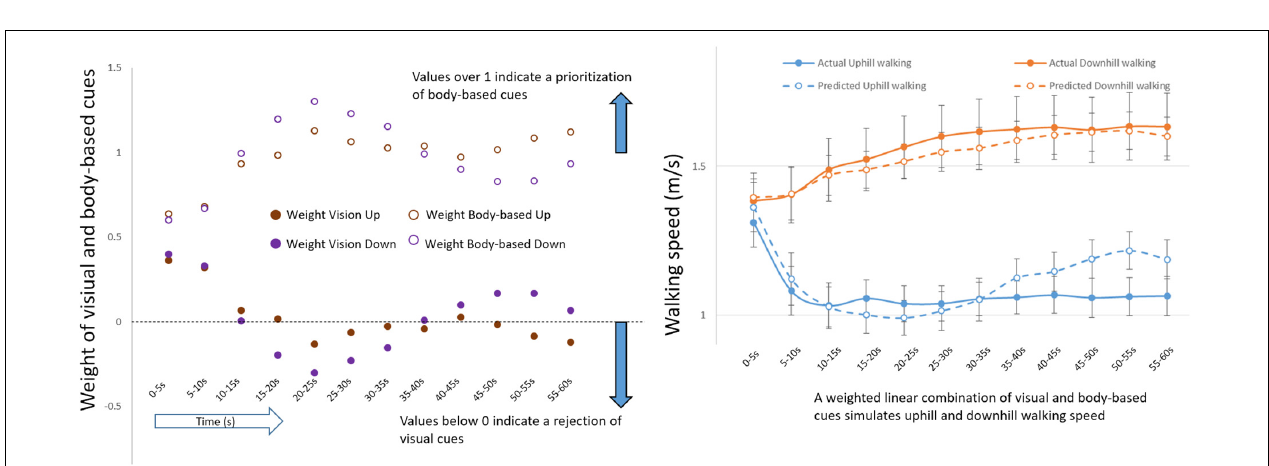
FIGURE 7 | Sensory reweighting. (Left) Weight of visual (filled circles) and body-based (unfilled circles) cues during uphill and downhill (congruent) walking. (Right) Actual changes in congruent walking speed (solid lines) as predicted by model weights from incongruent conditions (dashed lines) (See the Linearly Weighted Summation section in Materials and Methods). Errors bars represent standard